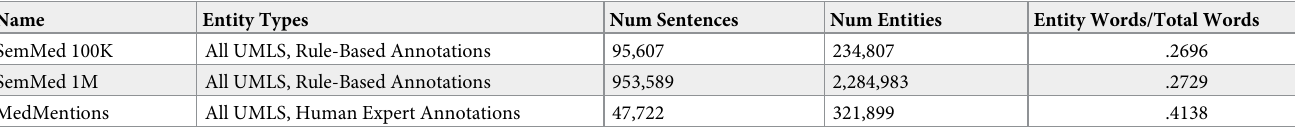
Table 1. Detailed information about each of our pre-training